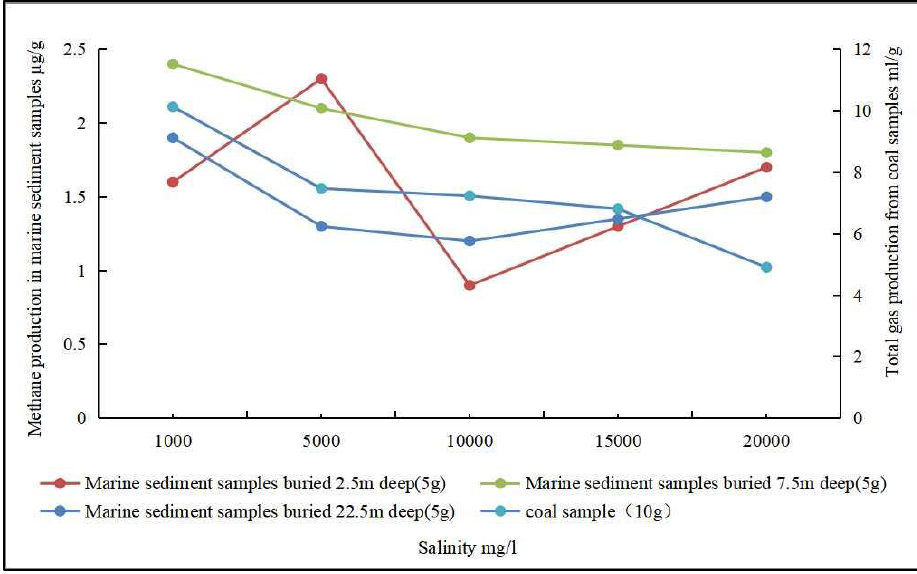
Figure 6. The relationship between salinity and gas production (Adapted from [101,102]).